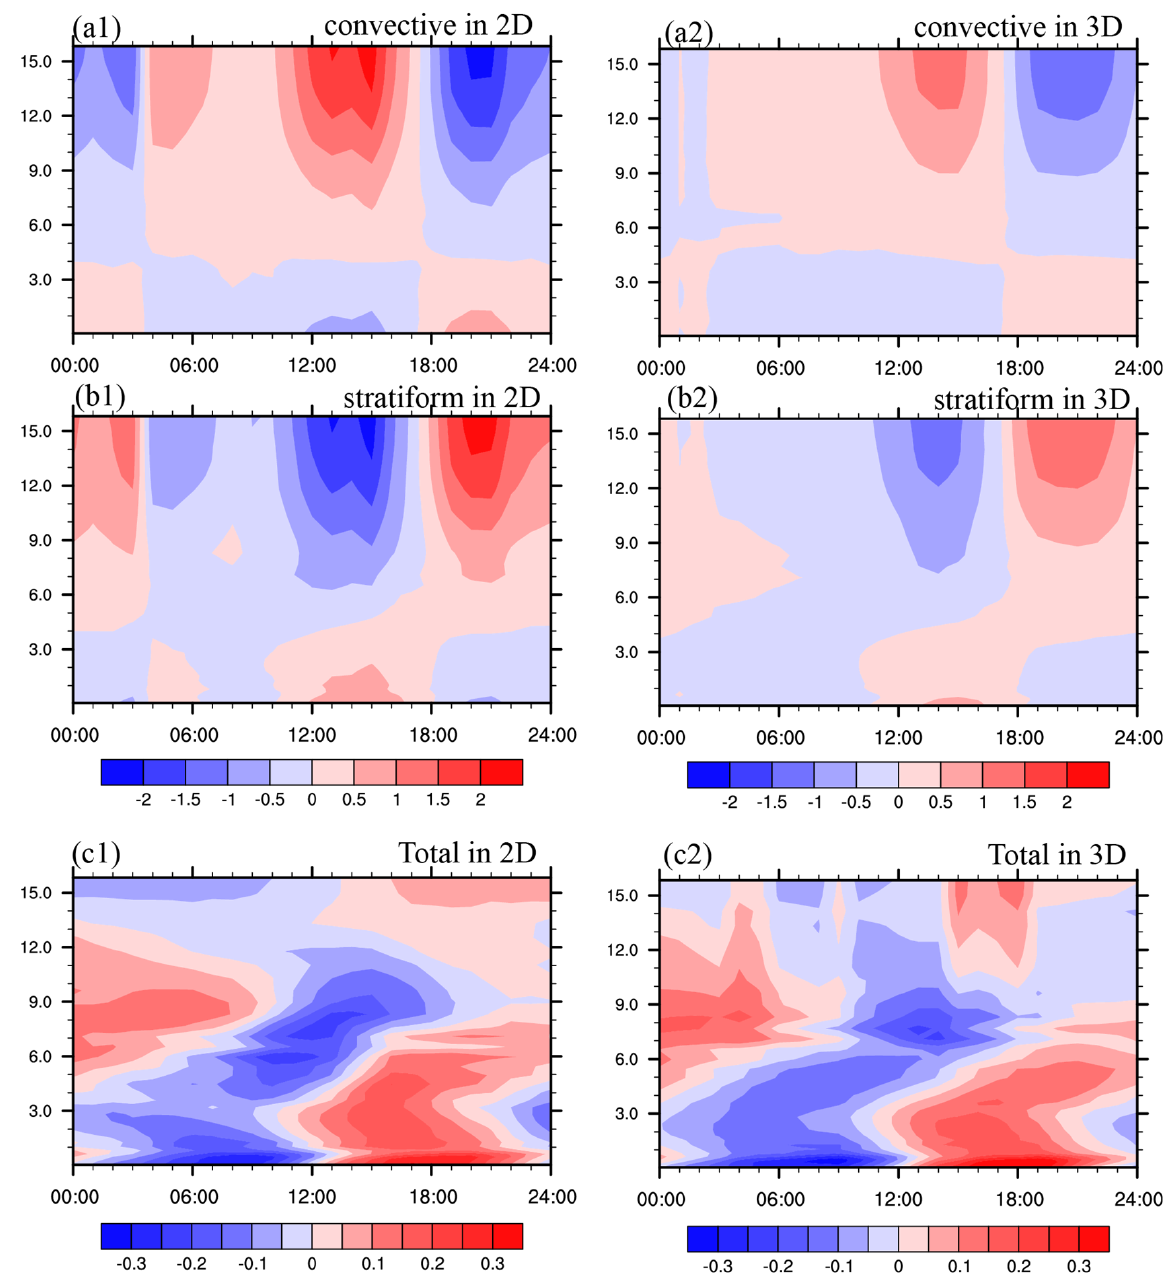
Figure 12. Diurnal composite of the perturbed temperature (°C) in the 2D ( left panel ) and 3D ( right panel ) model runs in ( a1 , a2 ) convective regions, ( b1 , b2 ) stratiform regions, and ( c1 , c2 ) the model domain. The perturbed values are calculated by subtracting the average temperature.